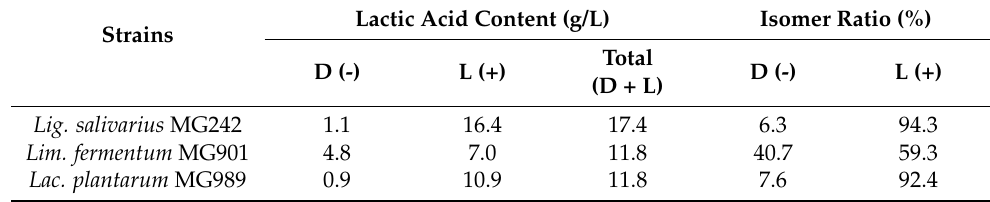
Table 4. Comparison of the lactic acid isomers produced by lactic acid bacterial strains.